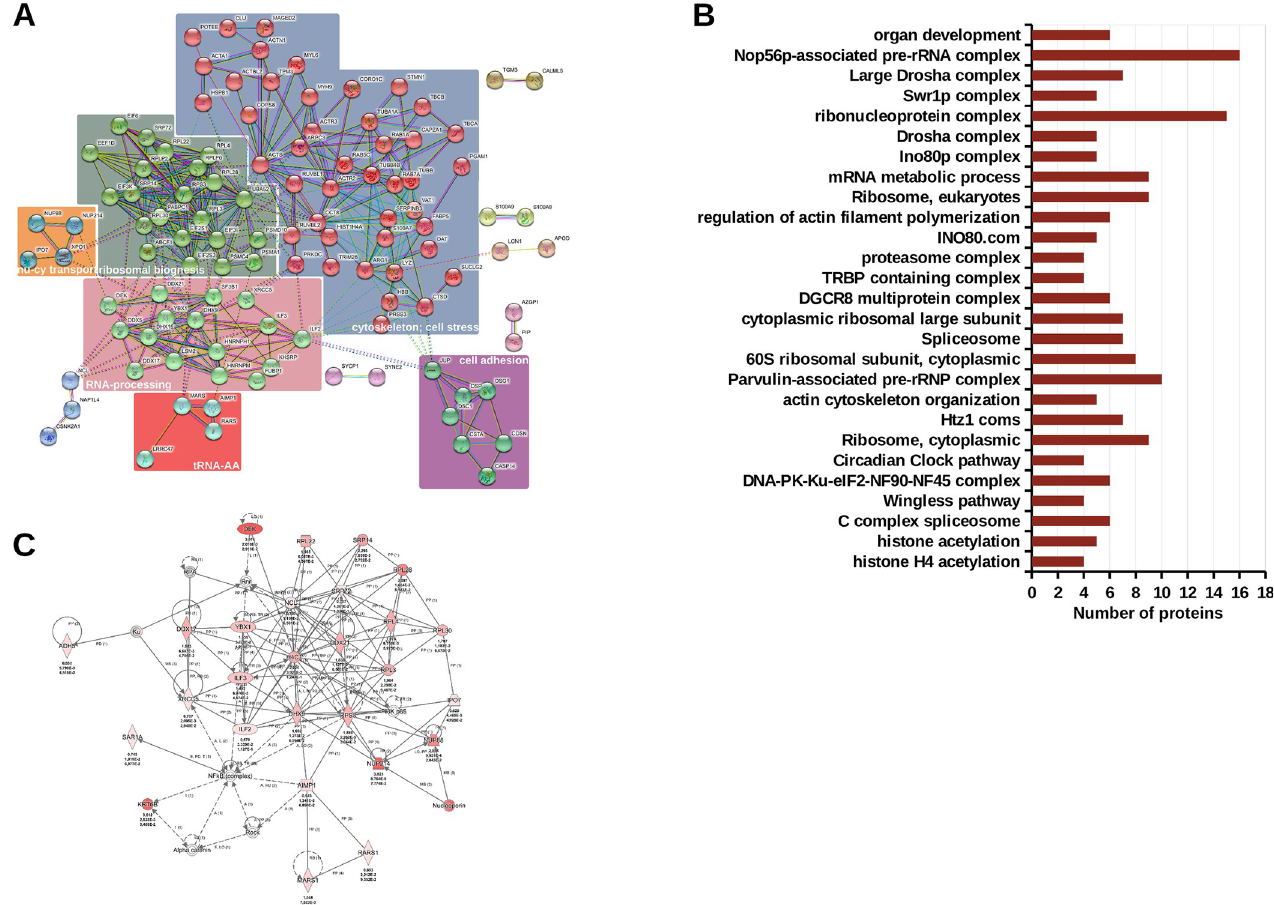
Fig 3. Functional analysis of DEK/NUP214 interacting complexes. A. STRING analysis. The STRING algorithm identified 6 clusters of at least four interactors indicating their function as evidenced by different colors. B. MIST analysis of the protein complexes formed by DEK/NUP214 interactors and their function–threshold was set at a minimum of 4 interactors. C. IPA network analysis of DEK/NUP214 interactors shows the network with the lowest p-value, the "RNA damage and repair network," corresponding to 27 DEK/NUP214 interactors involved in this single network. Each node in the network represents a gene, and the solid or dotted lines connecting them show a direct or indirect association, respectively. Red/grey nodes were the input genes detected in this study; white nodes are molecules inserted by IPA from the Ingenuity Knowledge Base.